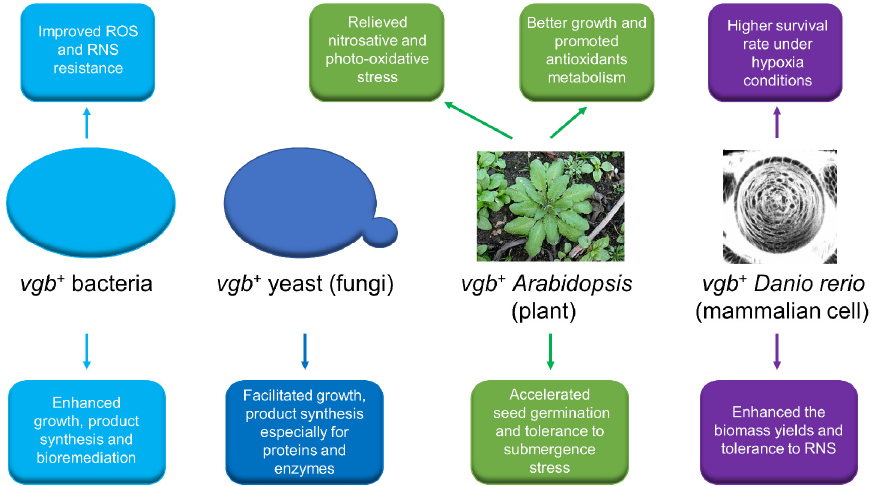
Figure 2. The potential applications of VHb in the field of metabolic engineering for bacteria [55,56], fungi [48,49], plants [57] and animals [58]. ROS: reactive oxygen species; RNS: reactive nitrogen species.